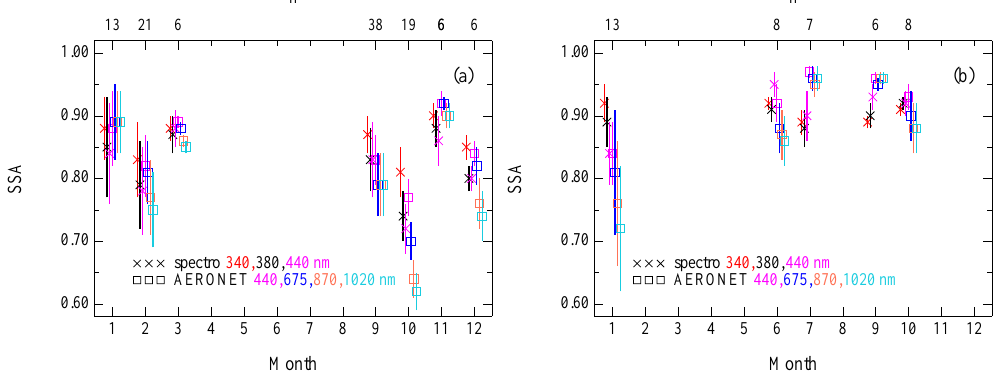
Fig. 6. Monthly means of SSA retrieved from spectroradiometer’s measurements (crosses) at 340 (red), 380 (black) and 440nm (magenta) and from AERONET/PHOTONS (squares) at 440 (magenta), 675 (blue), 875 (sienna) and 1020nm (turquoise): (a) in 2003; (b) in 2006. The vertical bars represent the dispersions around the means and n, on the top, is the number of observations used to determine the mean. For clarity the abscissa values of the various wavelengths have been slightly shifted around the month